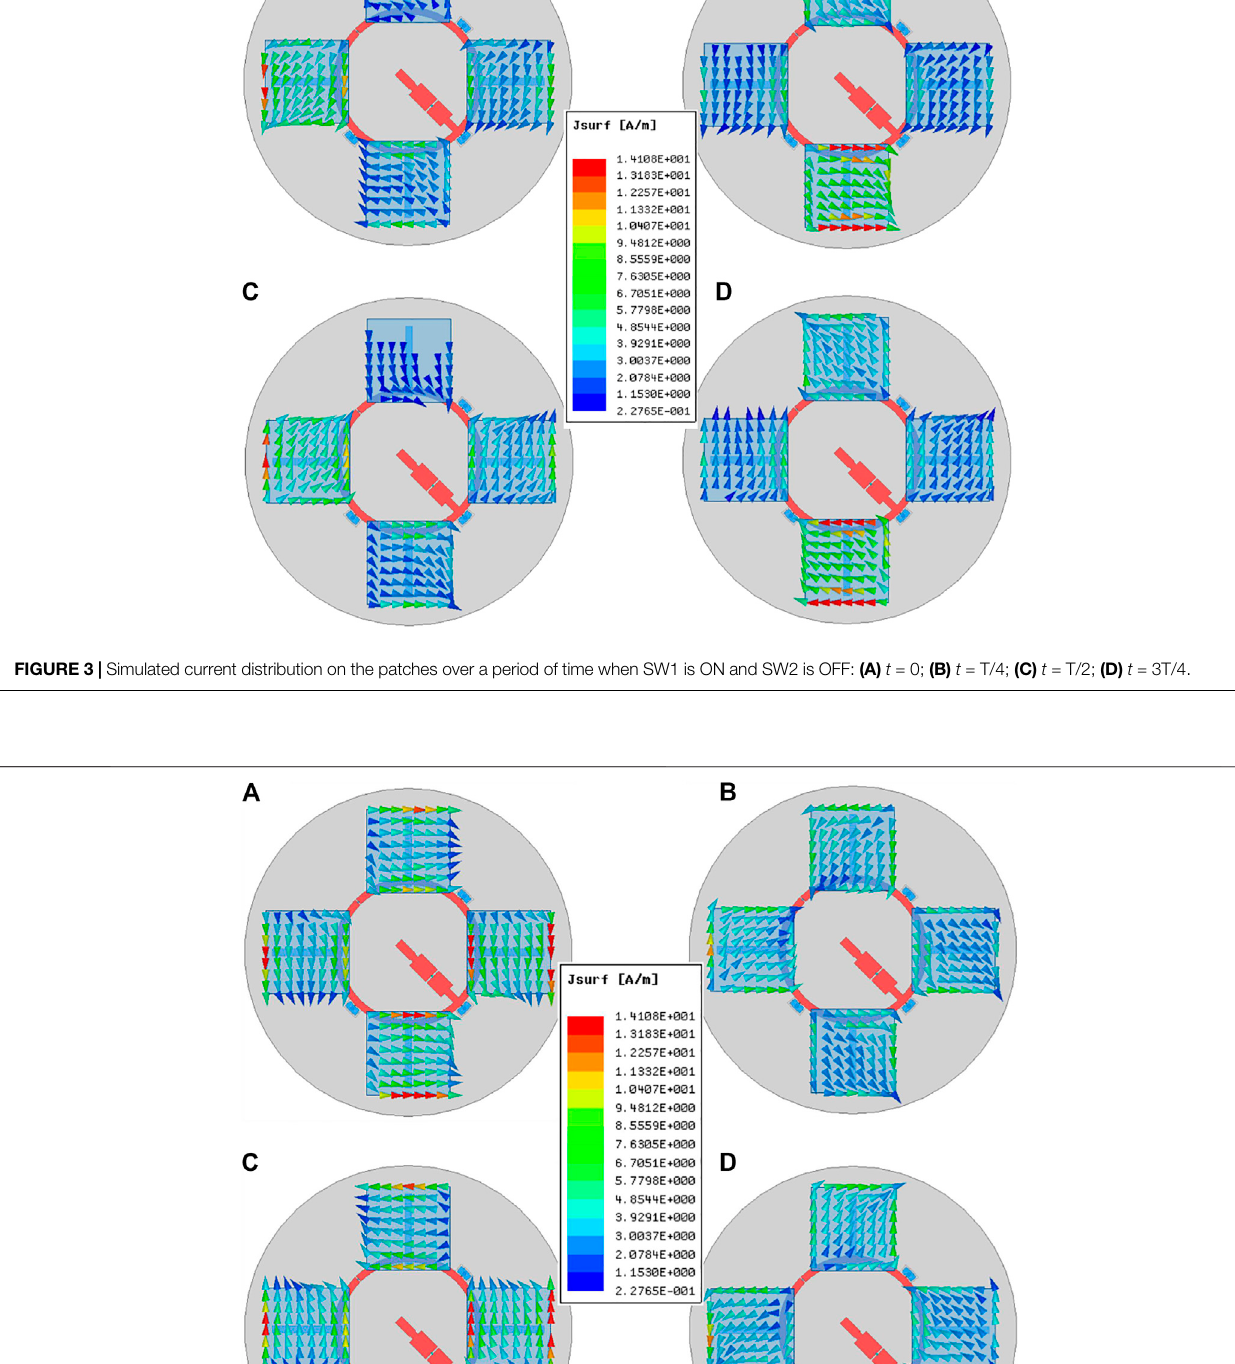
Frontiers in Physics |